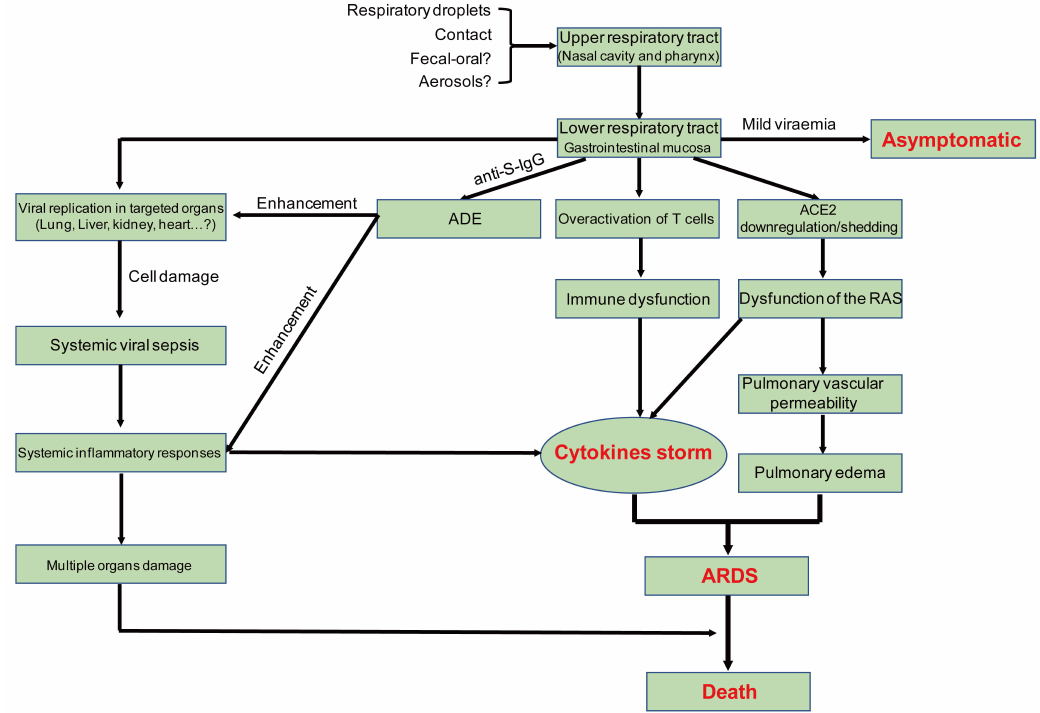
Figure 5. Postulated pathogenesis of SARS-CoV-2 infection. Antibody-dependent enhancement (ADE); ACE2: angiotensin-converting enzyme 2; RAS: renin-angiotensin system; ARDS: acute respiratory distress syndrome. Red words represent the important turning points in SARS-CoV-2